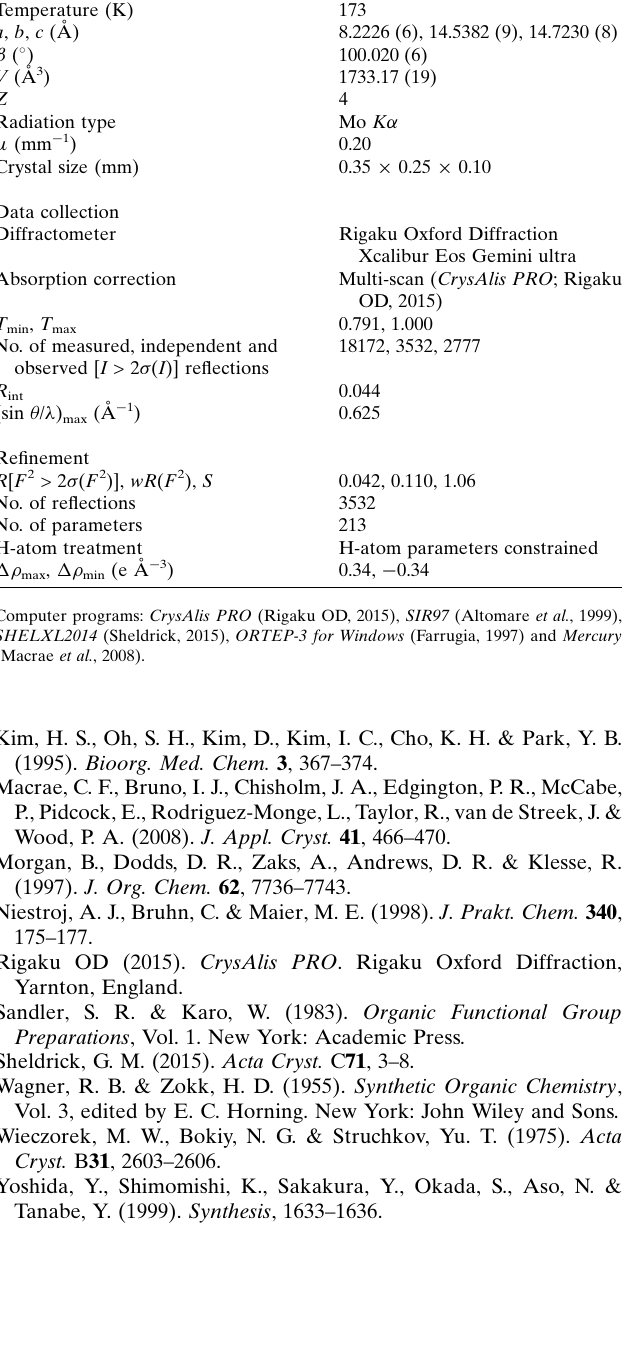
Crystal data Chemical